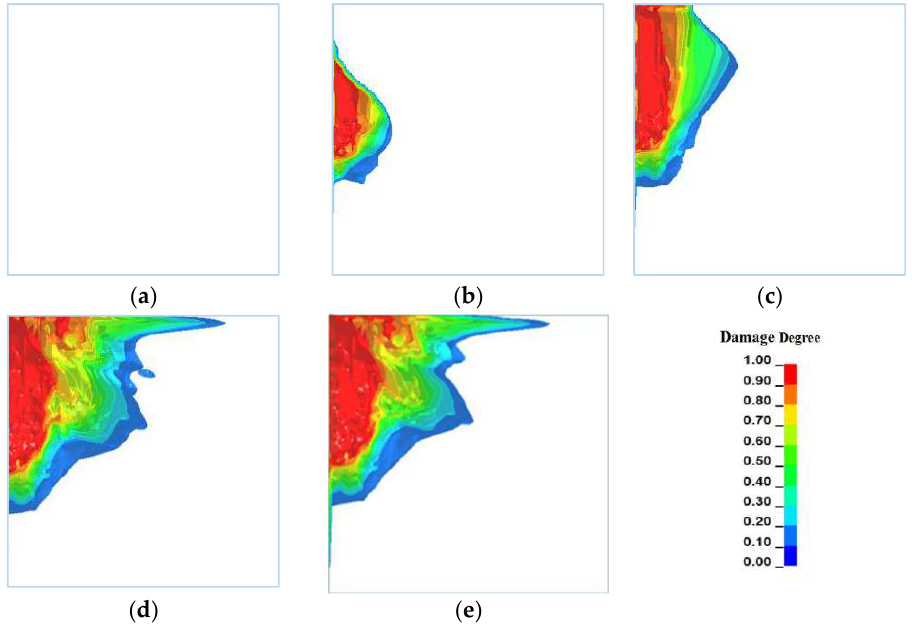
Figure 11. Blasting damage evolution law of groove-cavity in plane y = 0. ( a ) t =0 µs. ( b ) t = 200 µs. ( c ) t = 400 µs. ( d ) t = 600 µs. ( e ) t = 800 µs.